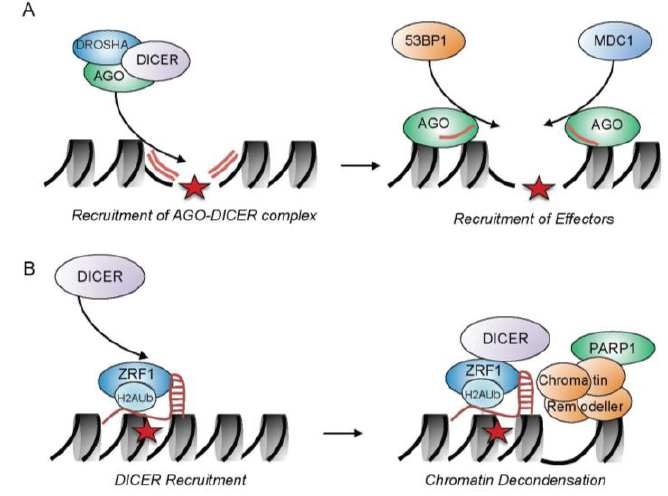
Figure 3. DICER dependent functions in NER and DSB repair. ( A ) Double-stranded RNAs (dsRNAs) are generated from antisense transcripts at the DSB and are subsequently processed by the DROSHA-DICER-AGO complex. AGO-bound ncRNAs localize at the DSB site (indicated as red star) and cause the recruitment of effectors, like 53BP1 and MDC1, by a yet-unknown mechanism; and ( B ) during GG-NER, H2A-ubiquitin-bound ZRF1 provides a binding platform for DICER. Multiprotein complexes consisting of DICER, ZRF1, PARP1 and, potentially, proteins from the SWI/SNF family of remodeling chromatin complexes cause a local decondensation of